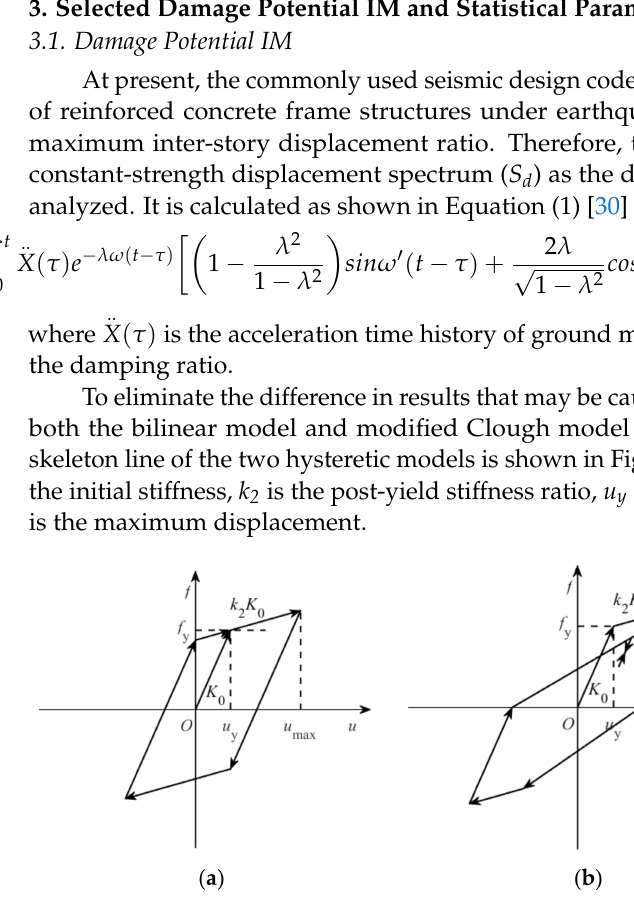
Figure 2. Force-displacement hysteresis loops simulated by the ( a ) bilinear and ( b ) modified Clough